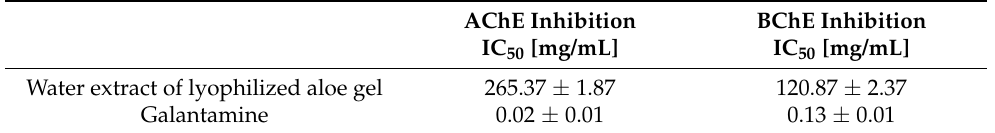
Table 4. Inhibition of AChE and BChE activity.